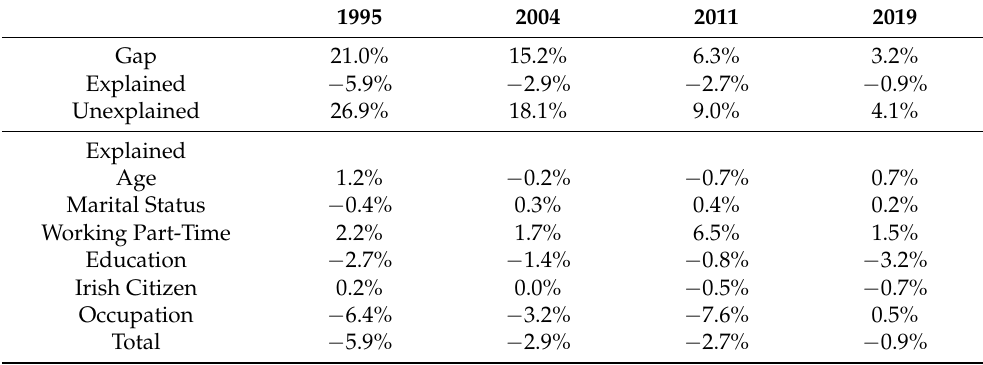
Table A8. Detailed decomposition results from RIF regressions for selected years at the 50th